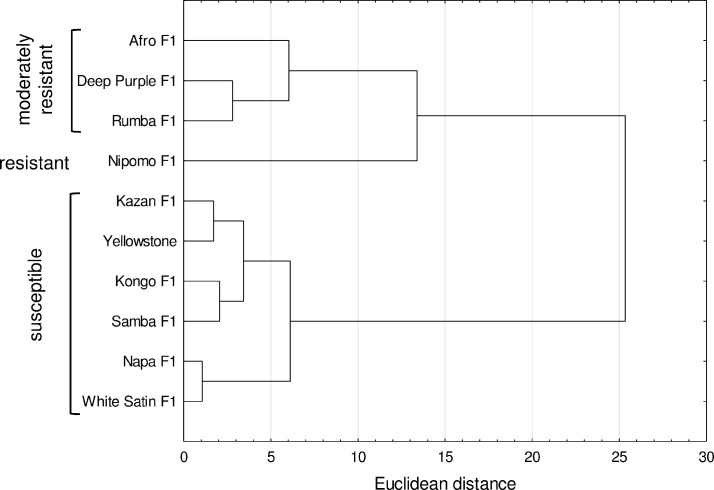
Dendrogram showing the clustering of carrot cultivars based on
antibiosis data: Pre-reproductive period (d),
reproductive period, fecundity of the female
(Md), total
progeny, intrinsic rate of increase
(rm), mean
generation time (T) and net reproduction rate
(Ro).